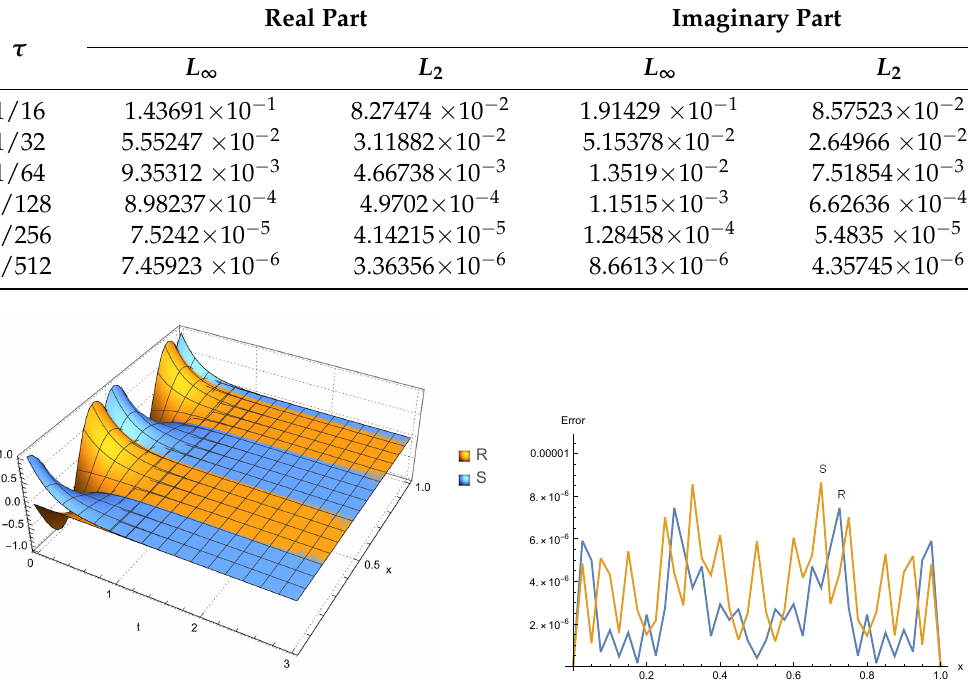
Figure 8. Computed approximation solutions and the error curves of R and S in Equation (3) for α = 0.5 τ = 1/512, a = 0, b = 1, and N = 40.